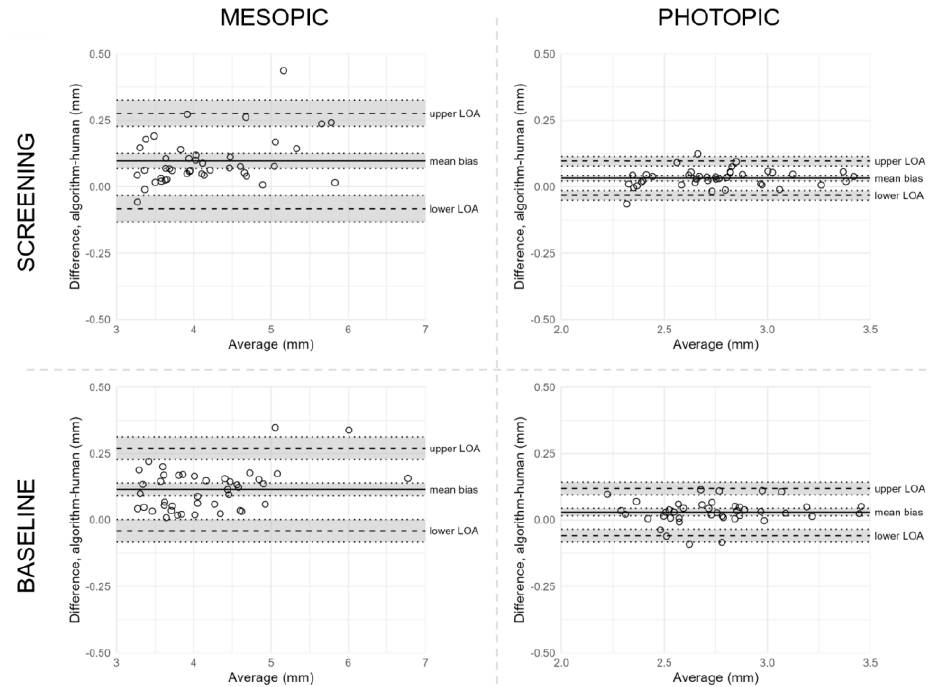
Figure 4. Bland–Altman plots of agreement between reading methods under mesopic and photopic conditions. Notes: Bland–Altman plots of agreement between reading methods under mesopic (left) and photopic (right) conditions at screening (upper) and baseline (lower). Differences between human-assisted reading and automated reading are plotted against their averages. The solid line marks the mean difference in pupil size between reading methods, the dashed lines mark the lower and upper limits of agreement (LOA), and grey shaded areas cover 95% CI of calculated estimates. Please note that the scales in Figures 3 and 4 are different. Abbreviations : CI = confidence interval; LOA = limits of agreement.